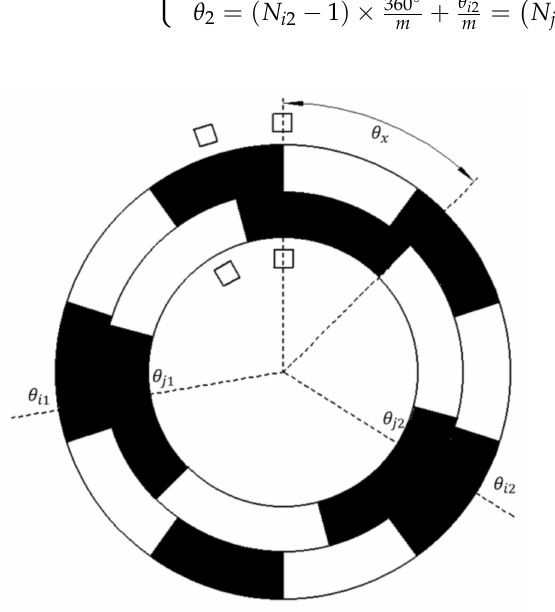
Figure 4. Simplified sketch of the magnetic encoder with two random